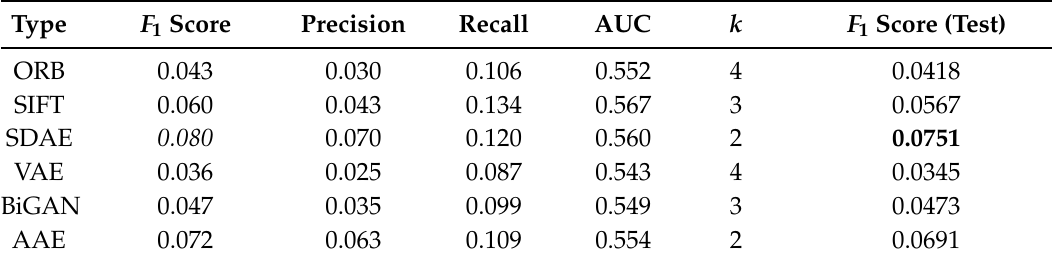
Table 5. The best F 1 scores obtained from the vector similarity search for each representation learned with the highest scores shown in